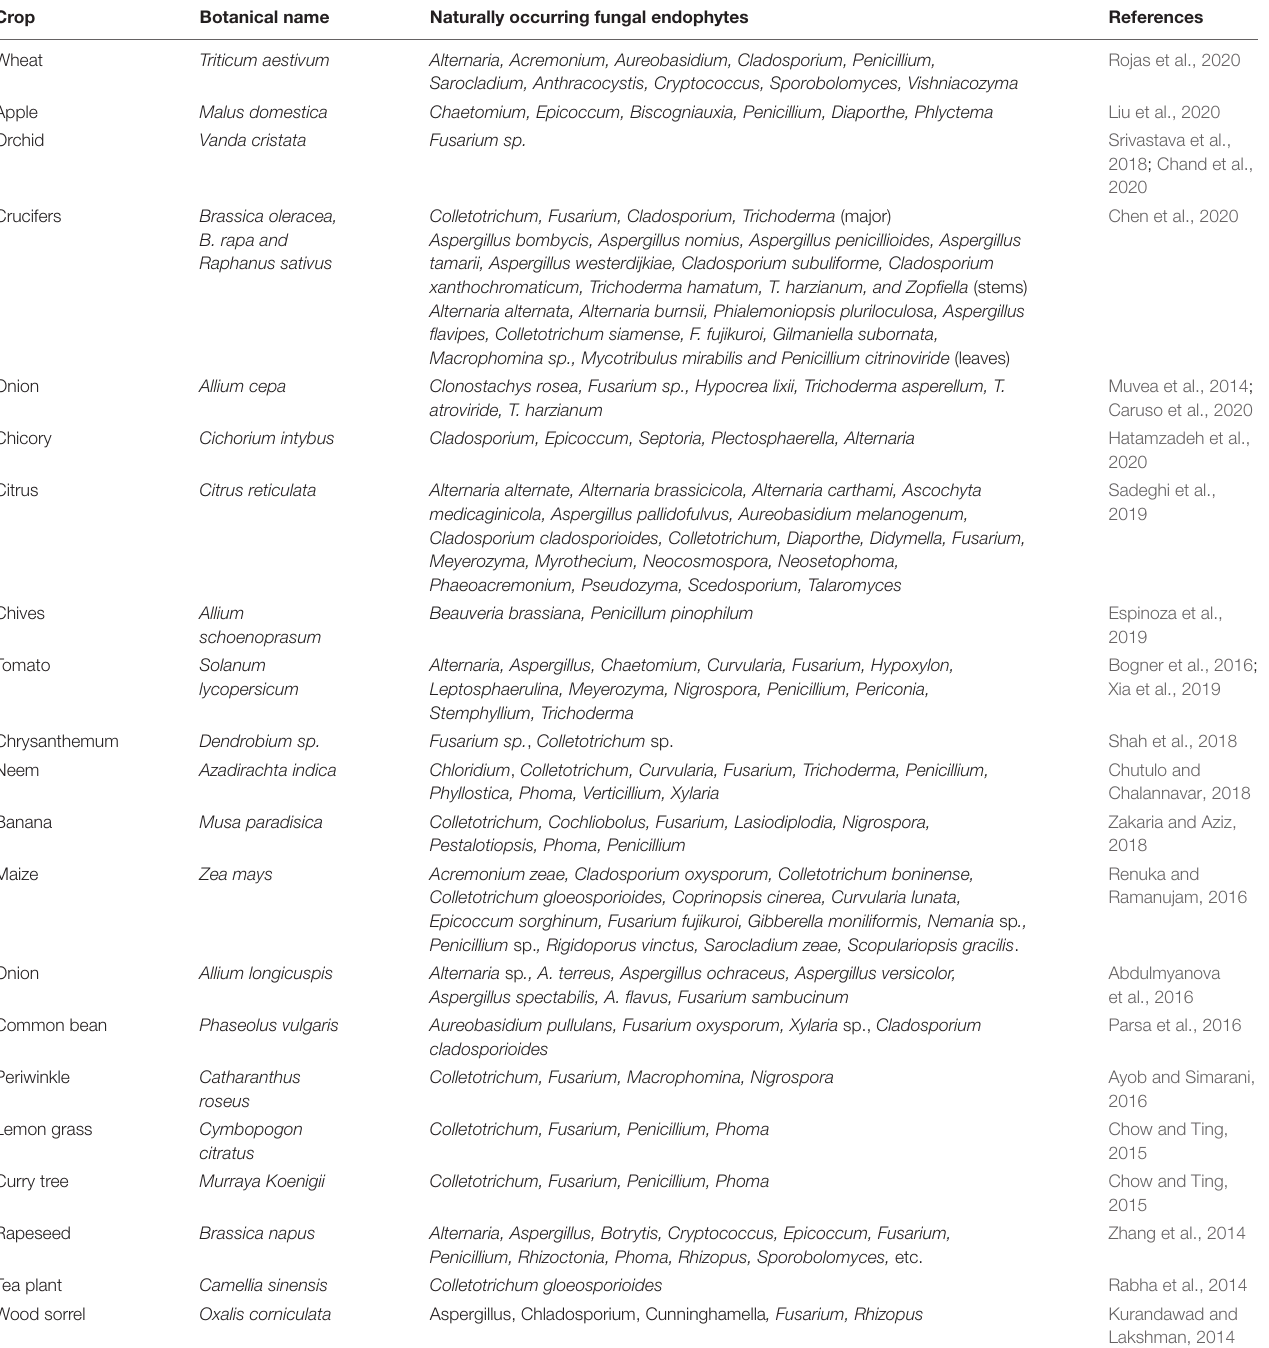
TABLE 1 | Fungal endophytes recently reported in important agronomic and horticultural crops grown